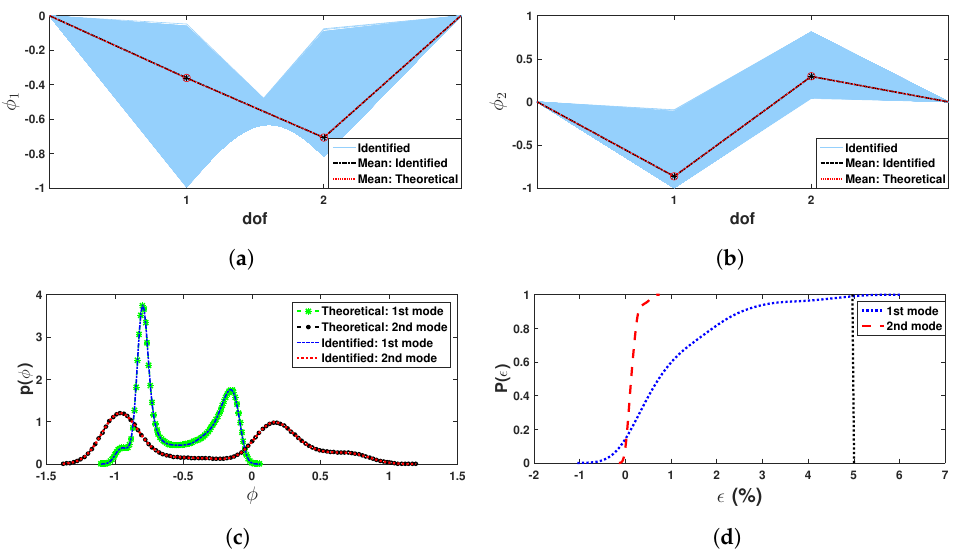
Figure 7. Modeshape estimation: identified ( a ) modeshape 1 & ( b ) modeshape 2; ( c ) pdf s of mode- shape and ( d ) cdf s of error in modeshape estimation.